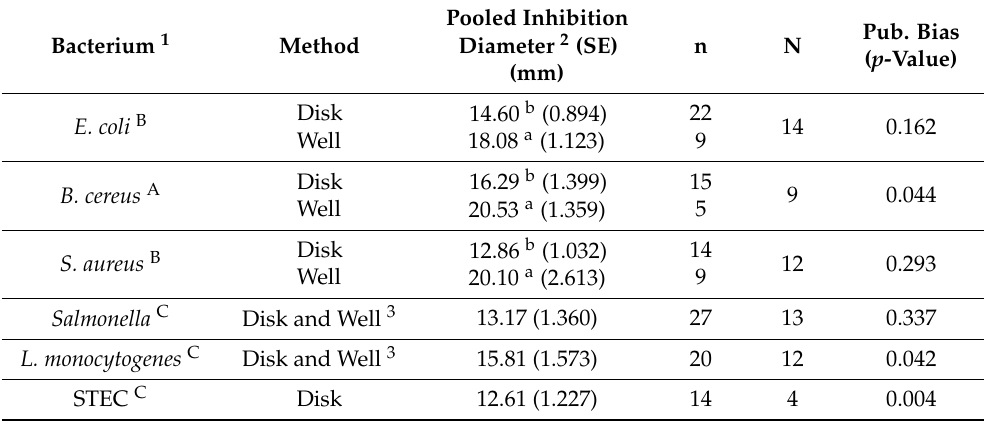
Table 3. Pooled inhibition diameters (mean and standard error, SE, in mm) of Syzygium aromaticum extracts against specific bacteria using meta-analysis models. Number of observations (n), number of primary studies (N), and p -value of the publication bias test are presented for each model.